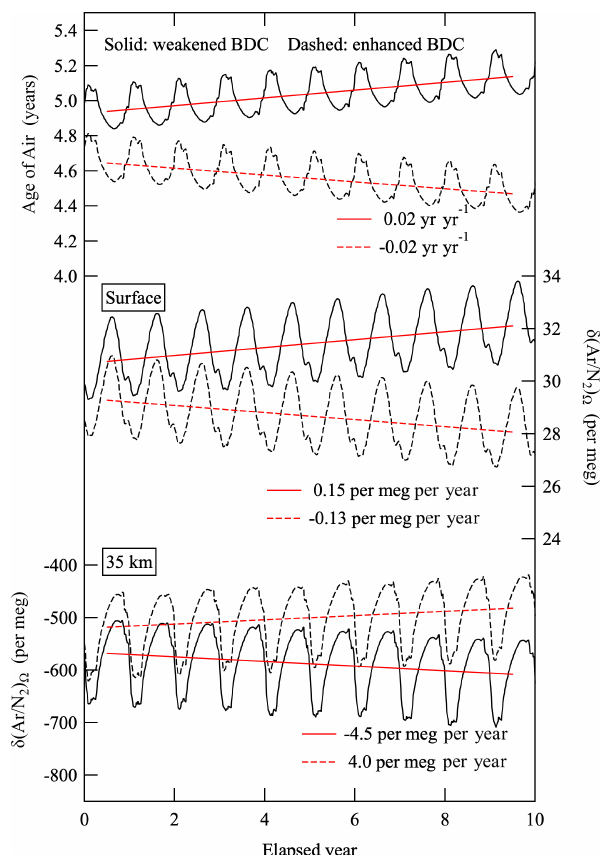
Figure 6. Age of air (AoA) in the stratosphere at 35km, δ (Ar / N 2 ) (cid:127) at the surface and δ (Ar / N 2 ) (cid:127) at 35km simulated by using the up- dated SOCRATES 2-D model for weakened- and enhanced-BDC conditions (see text). Red solid and dashed lines denote secular trends of δ (Ar / N 2 ) (cid:127) for the weakened- and enhanced-BDC simula- tions, respectively, obtained by applying linear regression analyses to the annual average